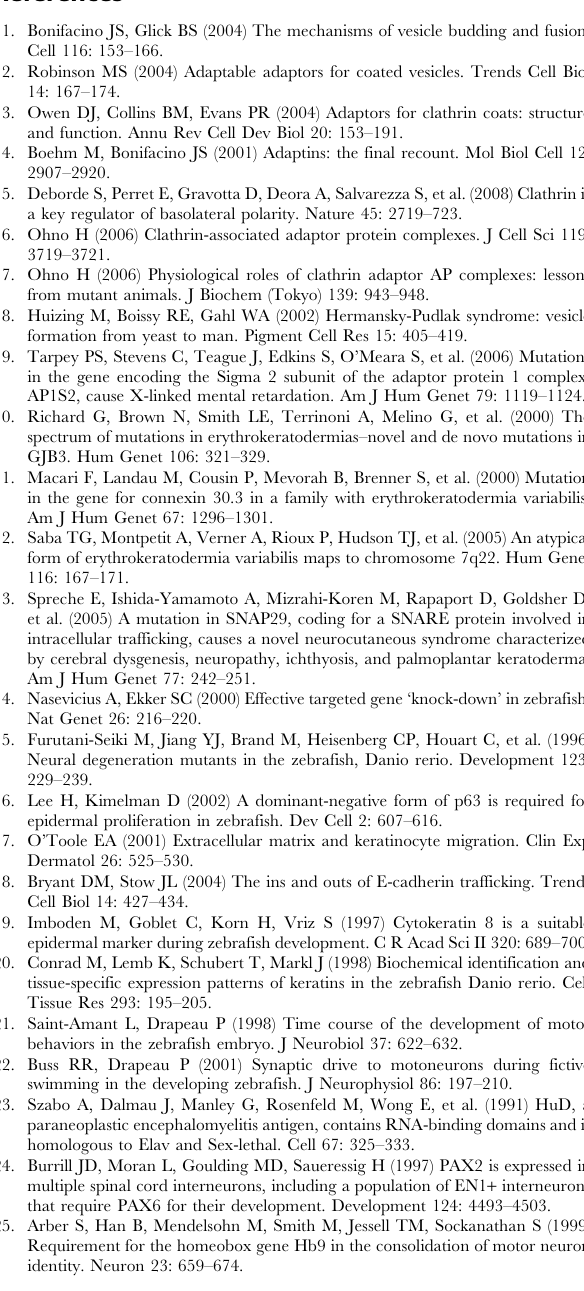
Table S1 Clinical features of affected individuals with MED- NIK. EKV: erythokeratodermia variabilis; VLCFA: very long chain fatty acids; NA: not available; mo: